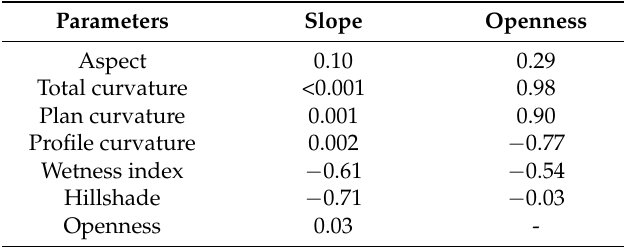
Table 1. Correlation coefficients of topographical parameters with slope and